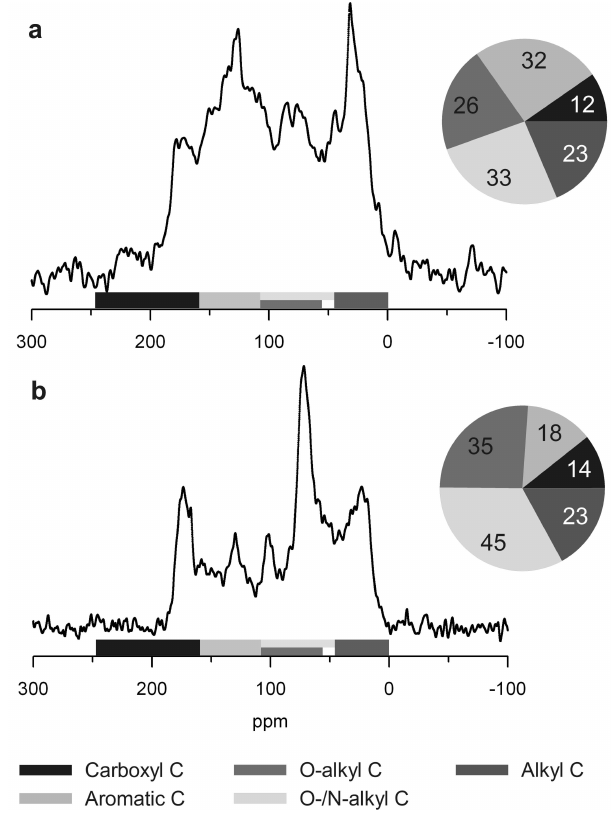
Fig. 4. Chemical composition of DOC revealed by solid-state CP- MAS 13 C NMR spectroscopy from (a) upwelling ground water and (b) pond water ( n = 1).